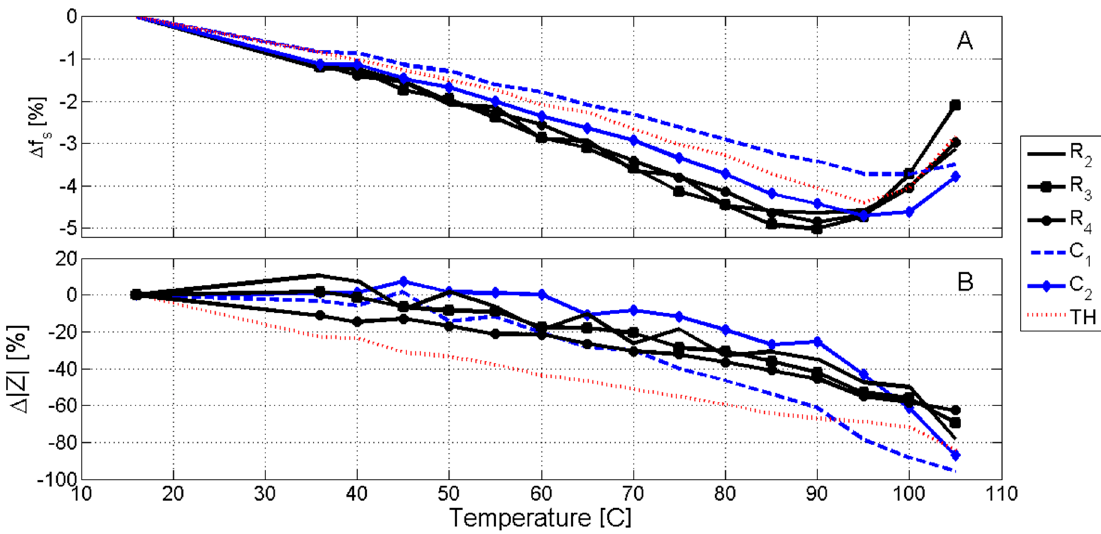
Figure 2. Thermal evolution of resonance modes: ( A ) Resonance frequency; ( B ) Modulus of the complex impedance. Results are expressed as a percentage of the value at room temperature.